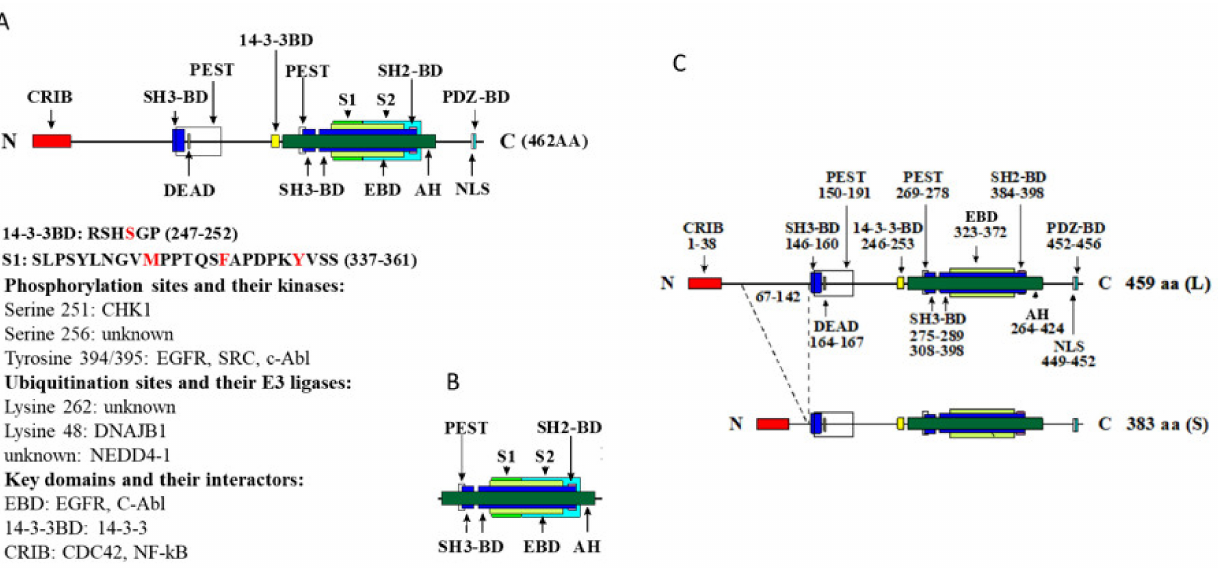
Figure 2. Linear structures of human and rat Gene 33. ( A ). Human Gene 33. Color-coded boxes represent different types of domains. CRIB: Cdc42/Rac interactive and binding domain, DEAD: DEAD box, PEST: PEST sequence, 14-3-3BD: 14-3-3 binding domain, SH3-BD: SH3 binding domain, EBD: EGFR or ErbB binding domain, SH2-BD: SH2 binding domain, AH: ACK homology domain, S1: segment 1, S2: segment 2, NLS: nuclear localization sequence, PDZ-BD: PDZ binding domain. The amino acid sequences of 14-3-3BD and segment 1 are shown with the key residues highlighted. Functionally significant phosphorylated residues and their kinases, key ubiquitination sites and their E3 ligase, as well as key domains and their known interactors are also listed. ( B ). Key features of the AH domain are shown. ( C ). Rat Gene 33 showing both the long and short splicing variants. The exact locations of domains are